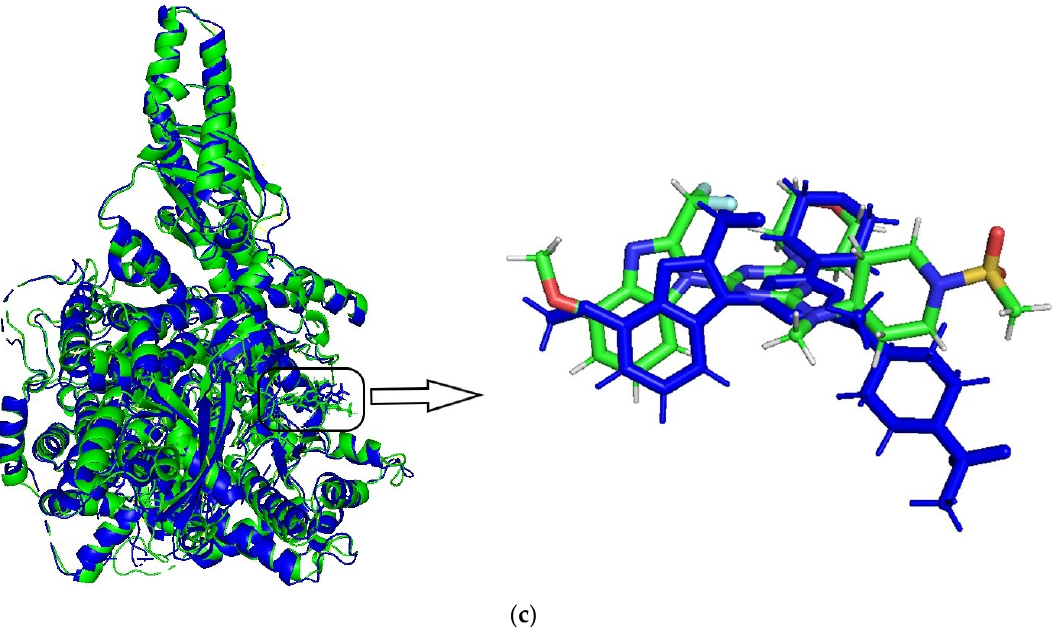
Figure 6. MD simulation results. ( a ) plot of the RMSD of the docked complex versus the MD simulation time in the MD-simulated structures; ( b ) Plot of the MD-simulated structure of the binding site with the ligand. Compound 29 was in the active site of PI3K α . H-bonds are shown as dotted green lines; active site amino acid residues are represented as sticks; the inhibitors are shown as sticks; ( c ) view of superimposed backbone atoms of the lowest energy structure of the MD simulation (blue) and the initial structure (green) for the compound 29 –PI3K α complex. Compound 29 is represented as a carbon chain in green for the initial complex and a carbon chain in blue for the lowest energy complex.